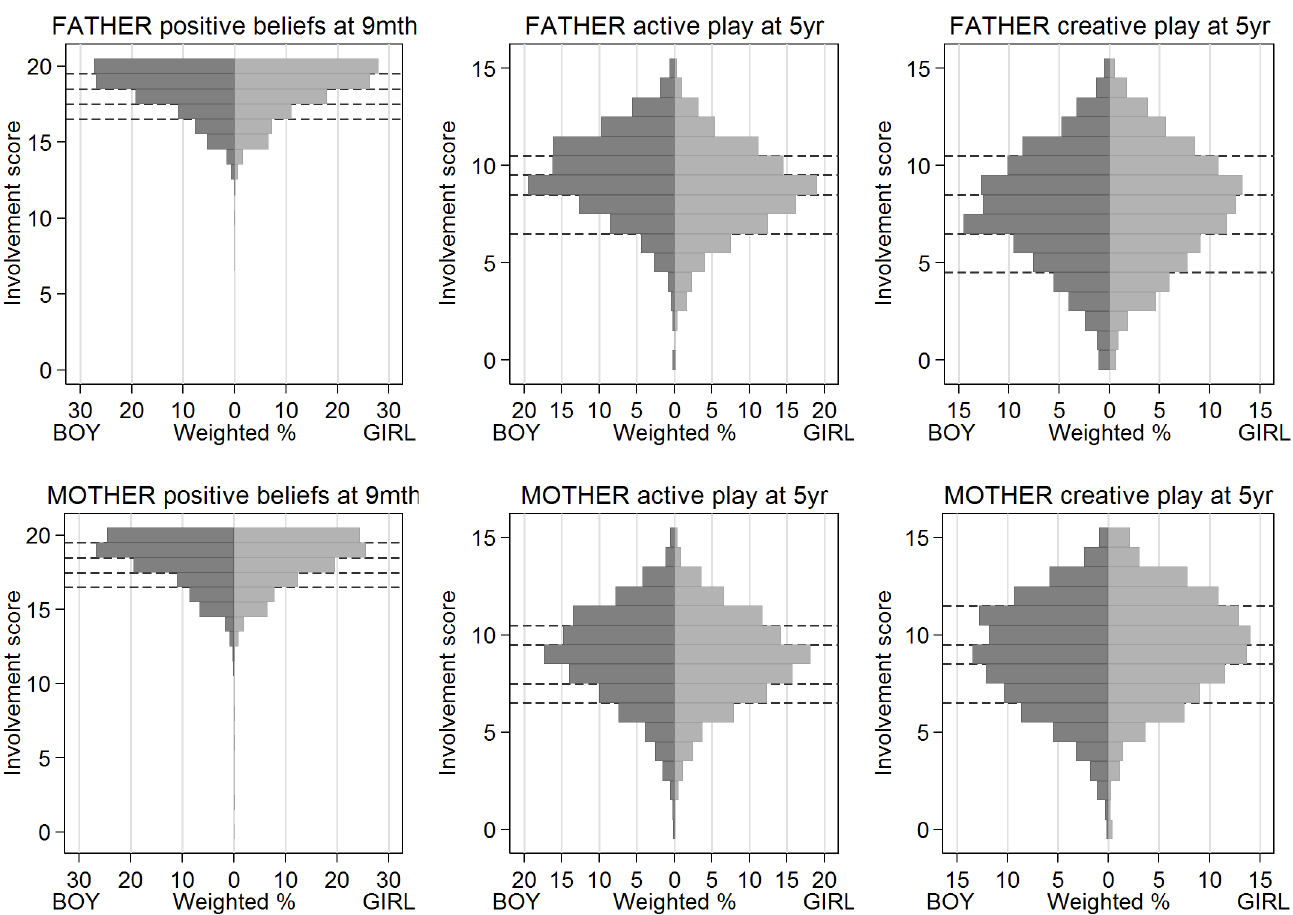
Fig 2. Distributions of both-parent composite involvement measures. Weighted % of study population for analysis period, excluding missing values. Dashed lines show categories used in regression